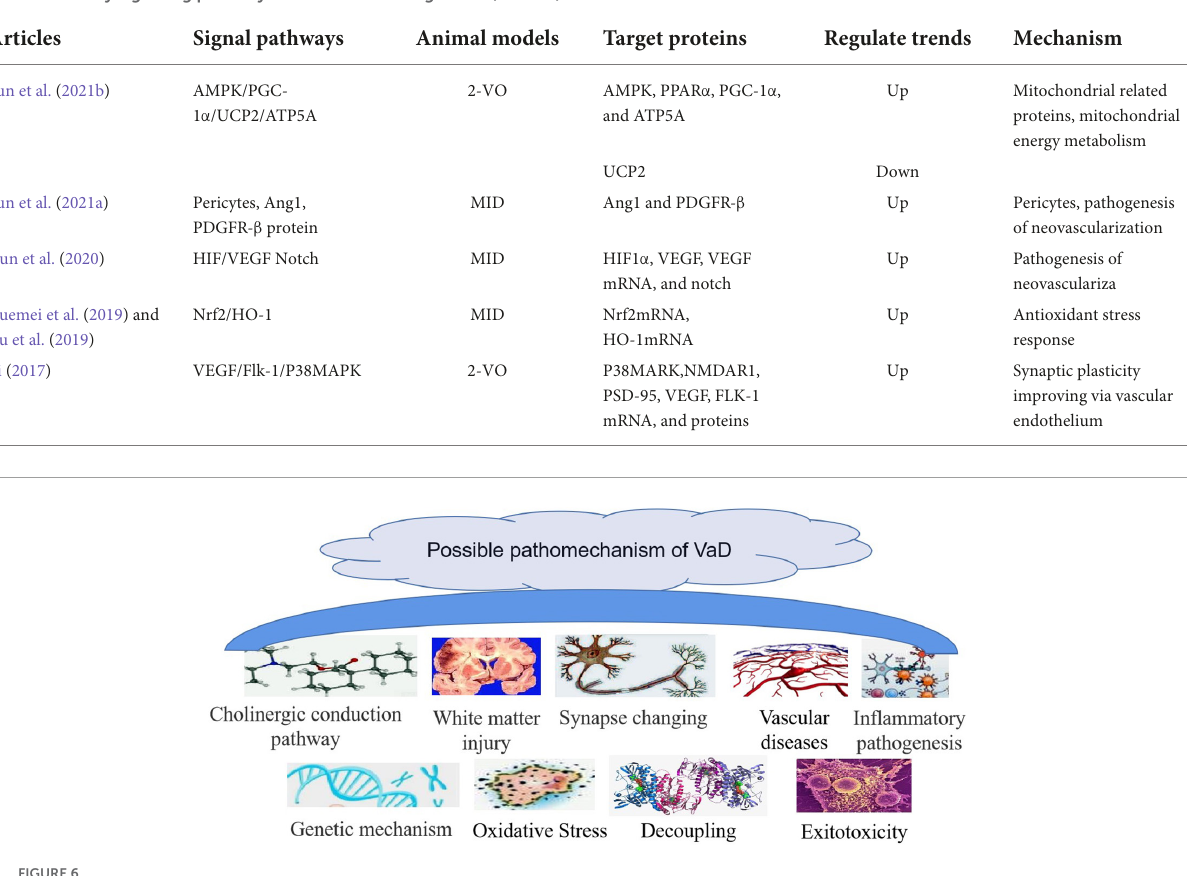
TABLE 2 Likely signaling pathways of Shen Ma Yi Zhi granule (SMYZG).